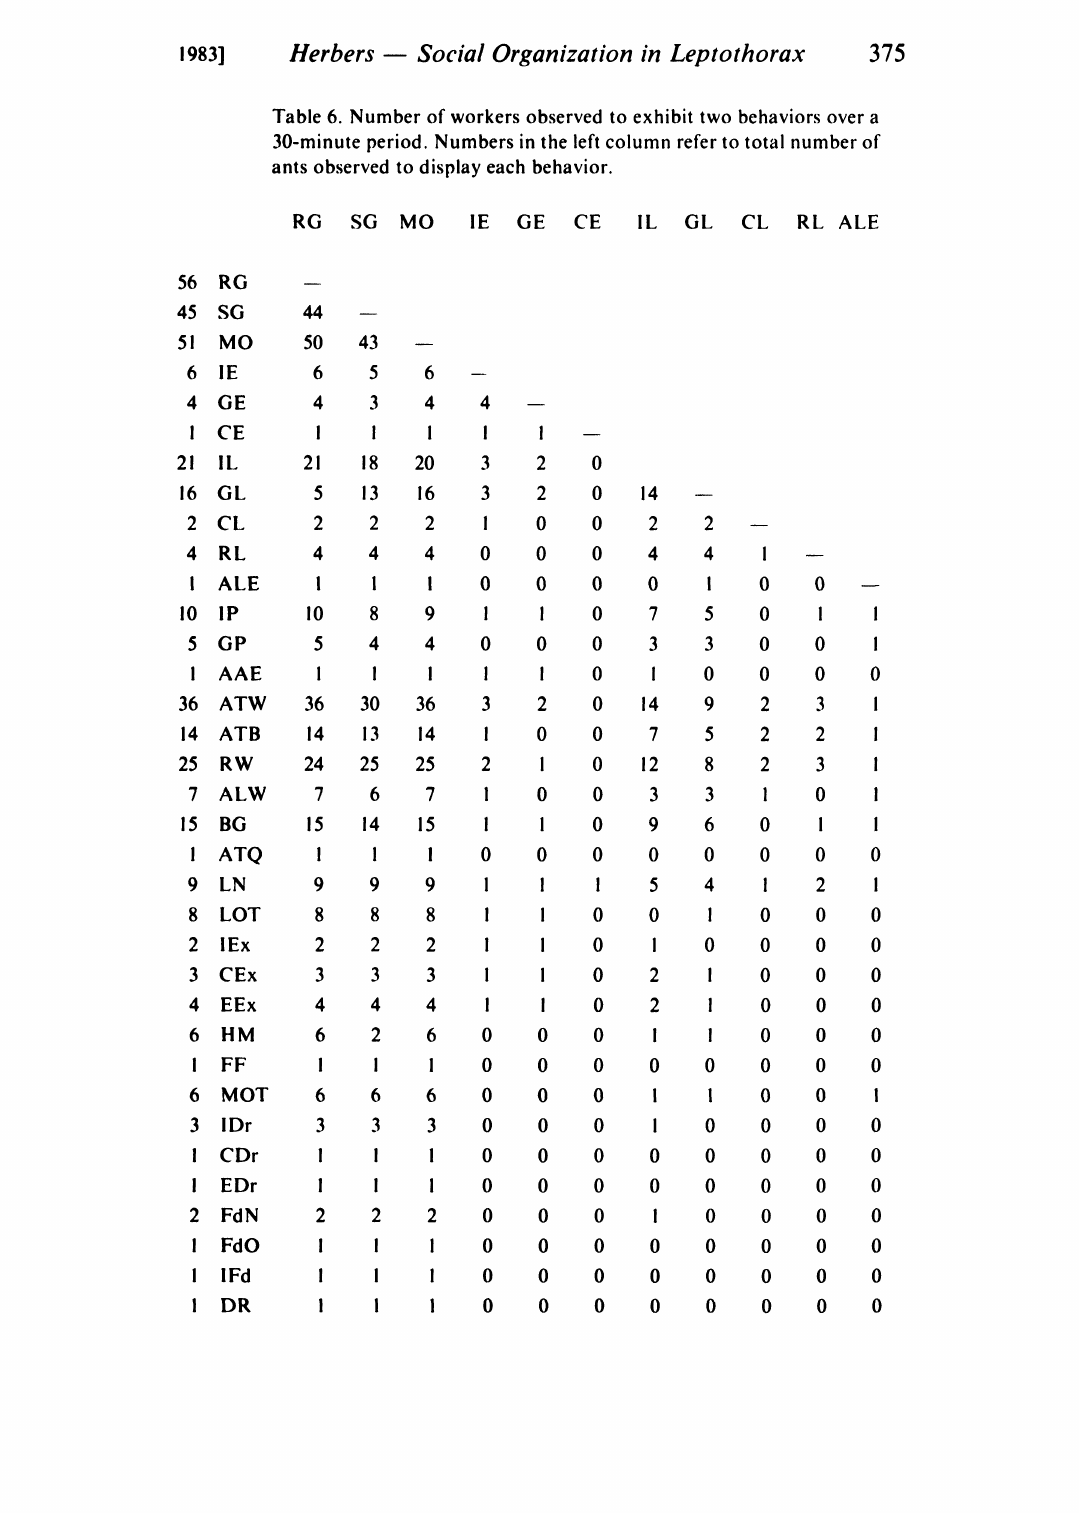
Table 6. Number of workers observed to exhibit two behaviors over a 30-minute period. Numbers in the left column refer to total number of ants observed to display each